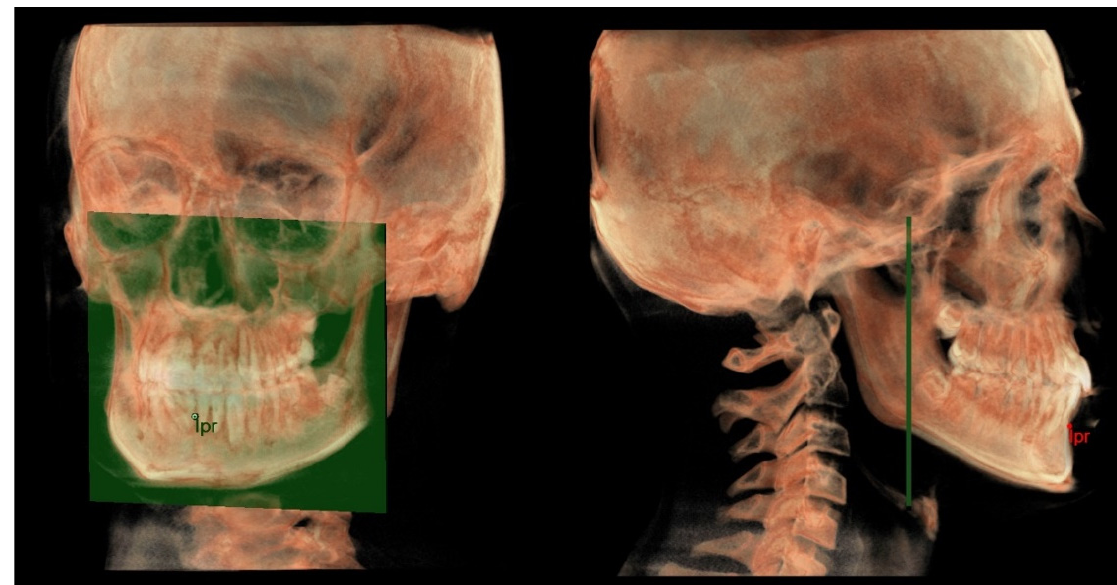
Figure 9. Mandibular dento-alveolar arch in 3D analysis.